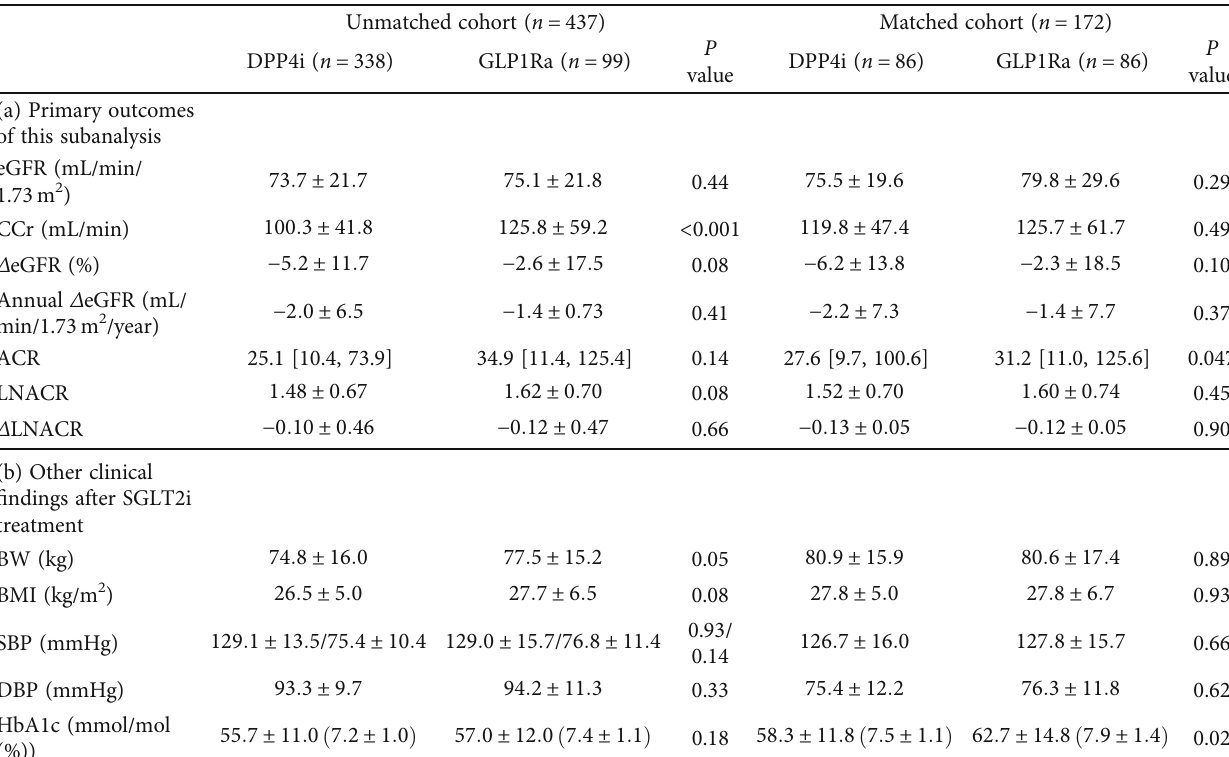
Table 2: Clinical fi ndings after SGLT2 inhibitor treatment in both models.